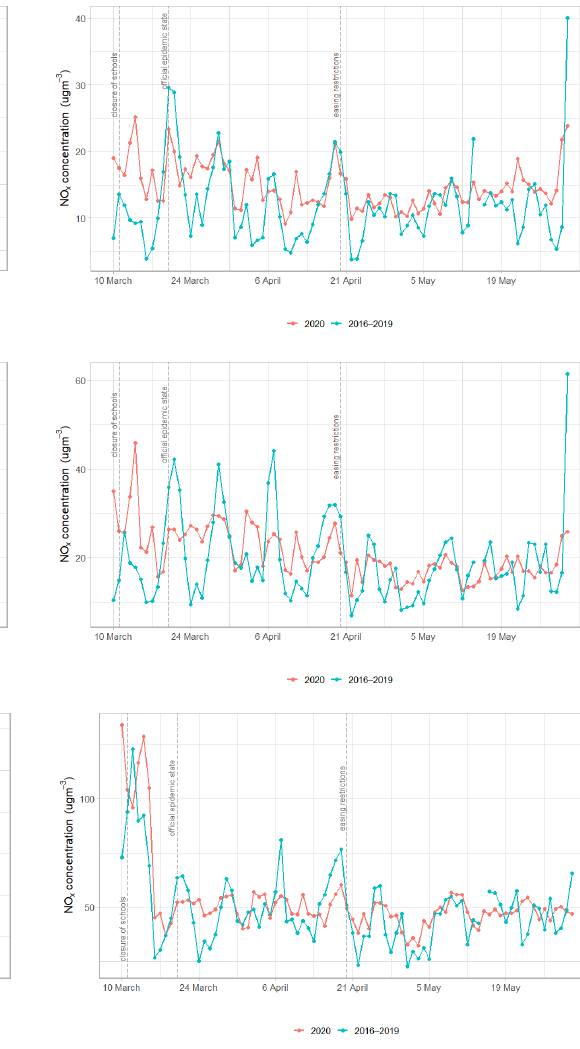
Figure 11. Average values of concentrations of air pollutants in the period 10 March–31 May 31 with standard deviation. The average daily concentrations of particulate matters have a strong relationship with the meteorological conditions in Wroc ł aw—the days are getting warmer and warmer—and thus there is a lower demand for additional heating of flats and reduction of low emissions (Figure 10). High concentrations occur mainly on non-working days, when residents spend the entire day at home and heat it more intensively. The first 9 days of the analyzed period were warm (day temperature was above 10 °C) resulting in a re- duced demand for domestic heating. Higher values of average concentrations in the ref- erence period are the result of aggregating by averaging over 4 years of data, i.e., no in- fluence of meteorological conditions in one specific year could be seen. On 21 March 2020, the daytime temperature dropped below 5 °C and negative temperatures were recorded at night, which resulted in the intensification of heating and, as a result, an increase in